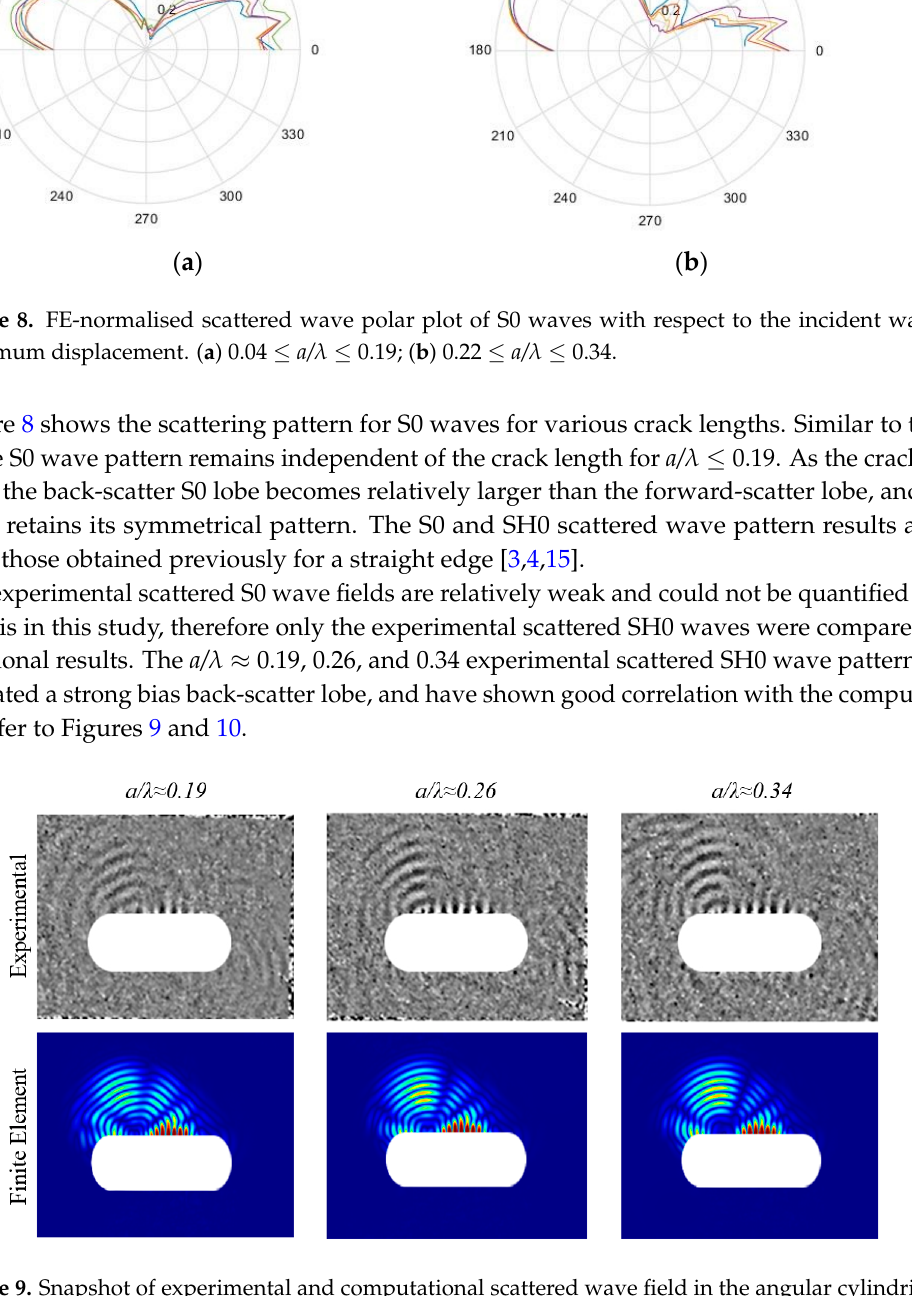
Figure 9. Snapshot of experimental and computational scattered wave field in the angular cylindrical component showing a dominant scattered SH0 wave field at time 70 µs for a/ λ ≈ 0.19, a/ λ ≈ 0.26 and a/ λ ≈ 0.34.